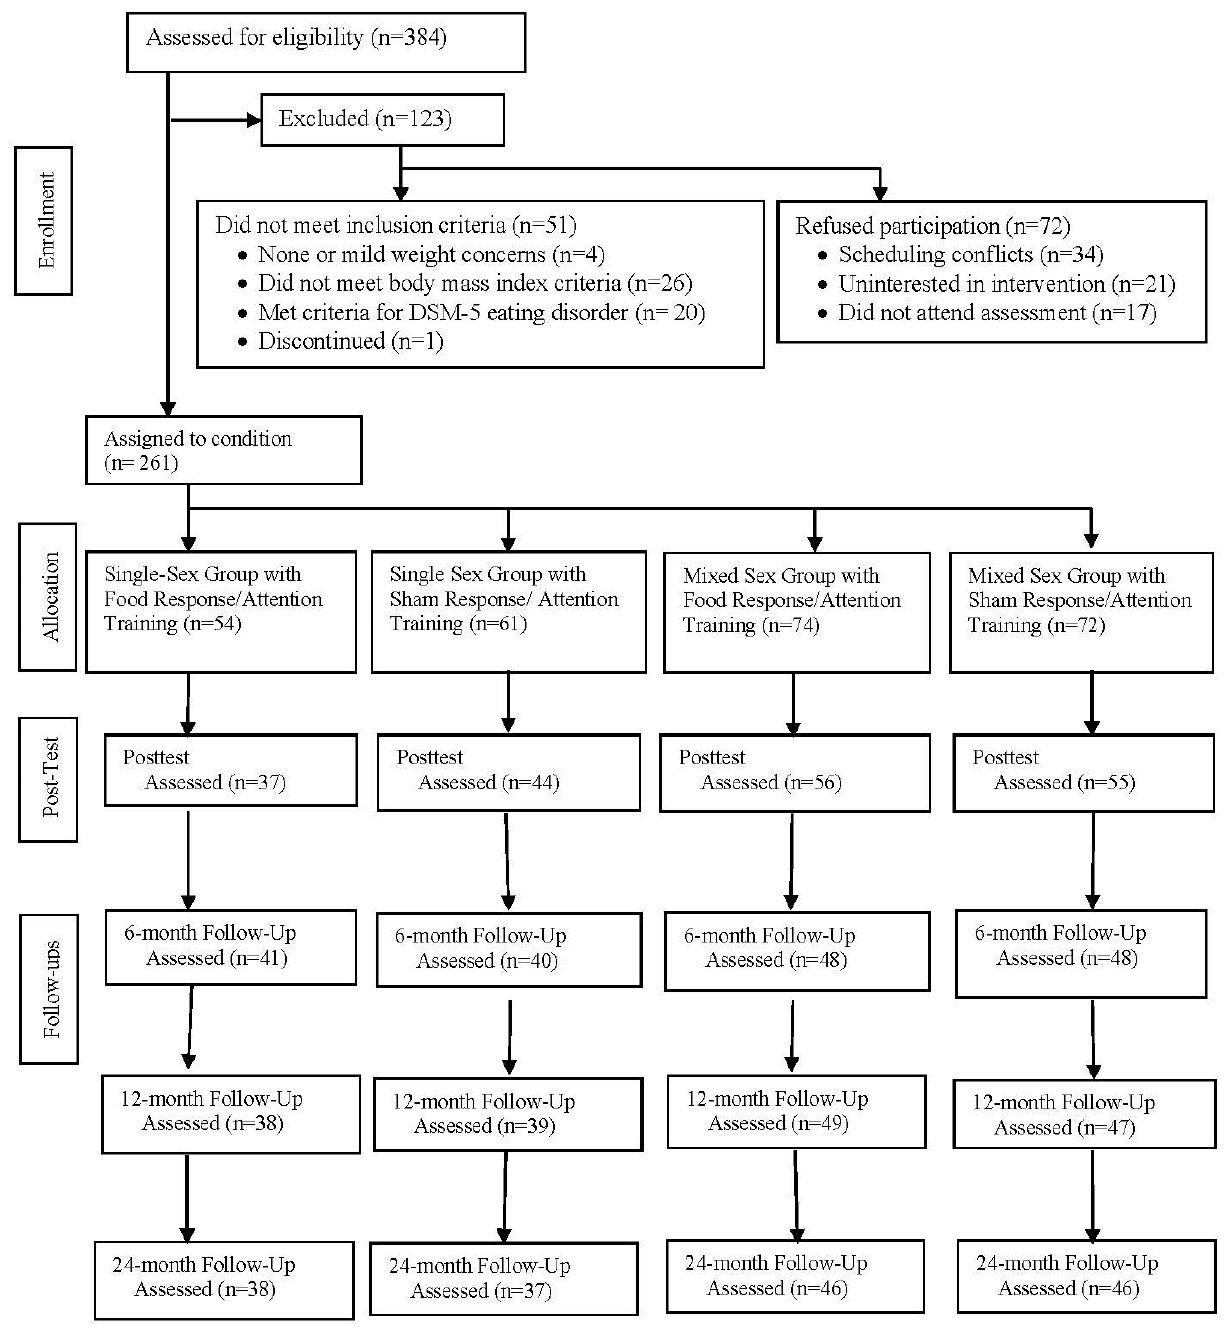
Figure 1. Participant flow through the